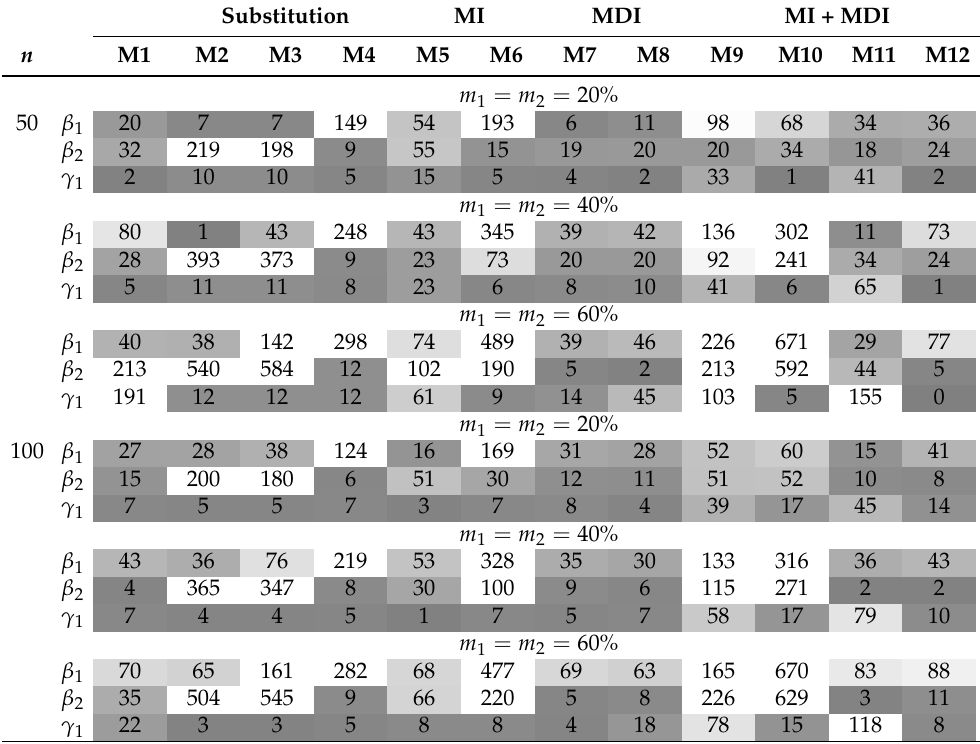
, j = 1,2 is subjected ij